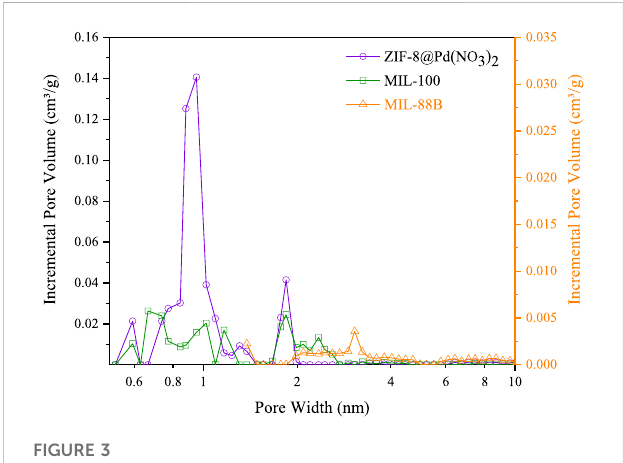
FIGURE 3 Pore size distributions calculated from BET – Tarazona NLDFT theory assuming cylindrical geometry, based on N 2 adsorption data.